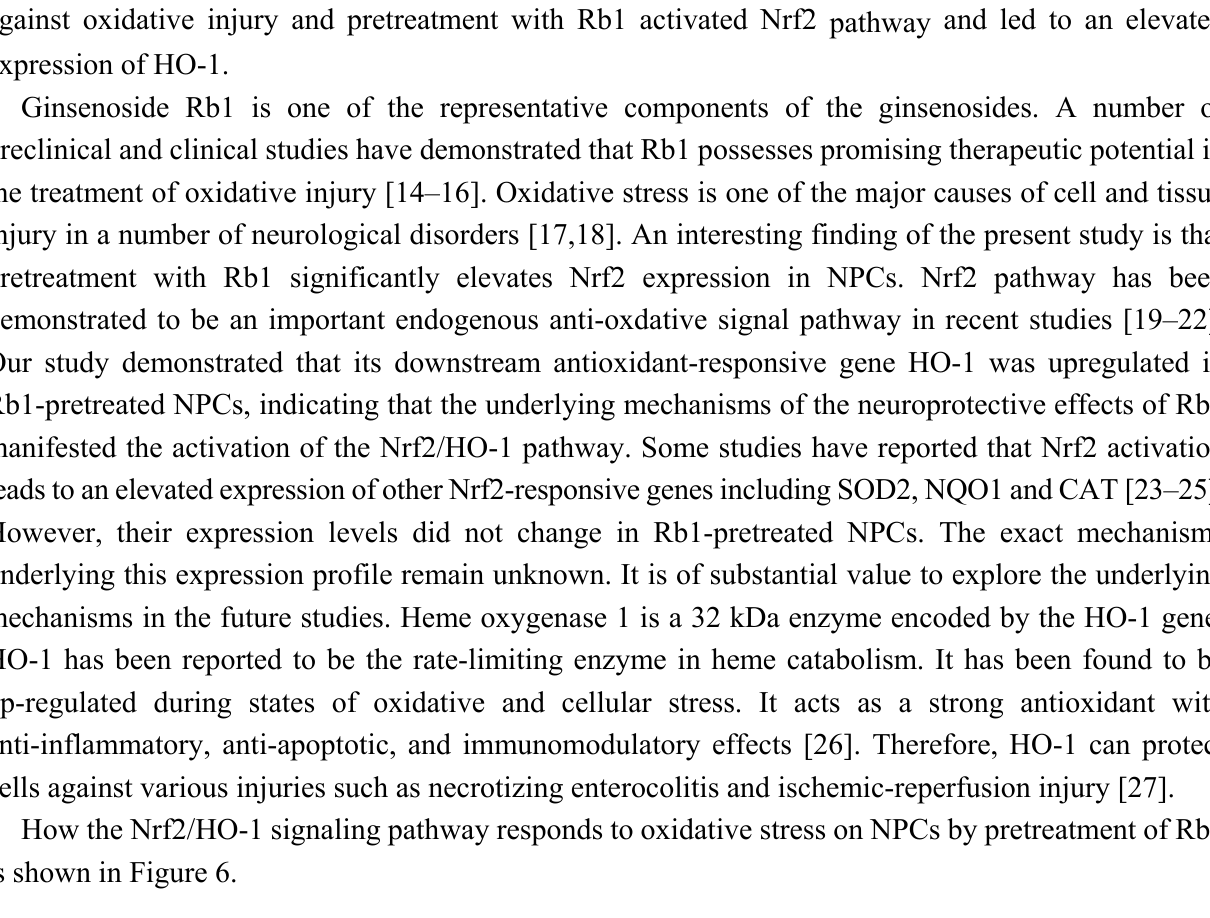
Figure 6. Proposed mechanisms underlying the cellular responses to t-BHP after pre-treatment with Rb1 via Nrf2/HO-1 signaling